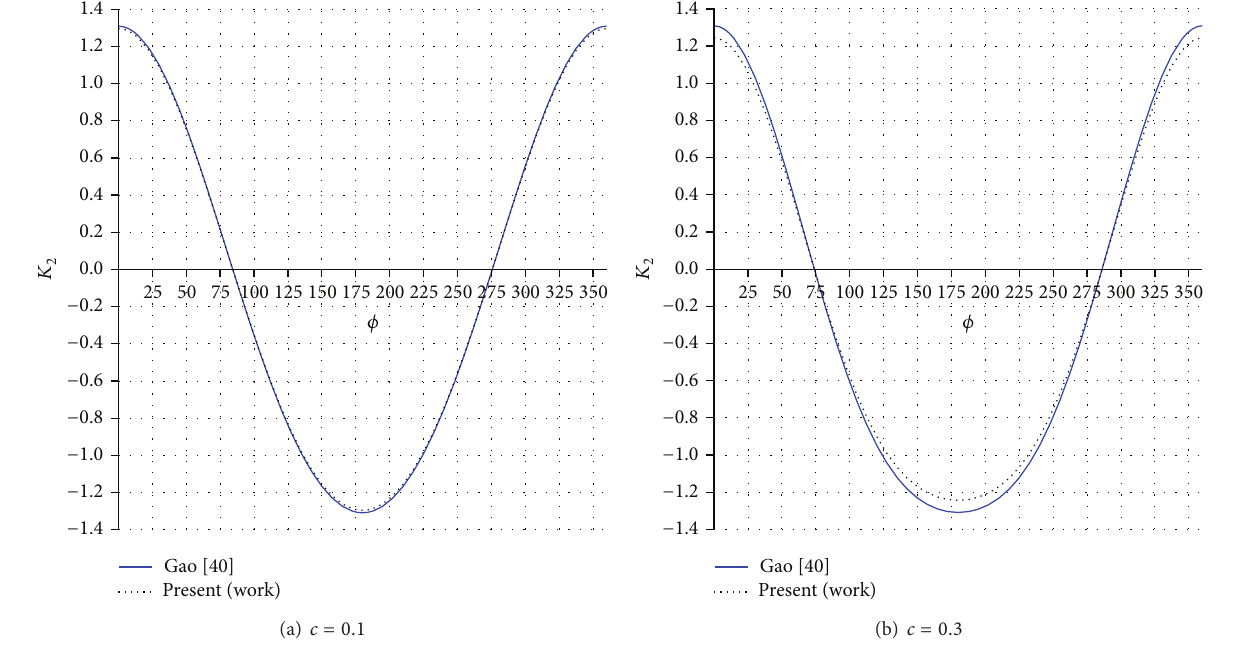
Figure 3: The 𝐾 2 (𝜙) for 𝑓(𝜁) = 𝜁 + 𝑐𝜁 2 at different 𝑐 .